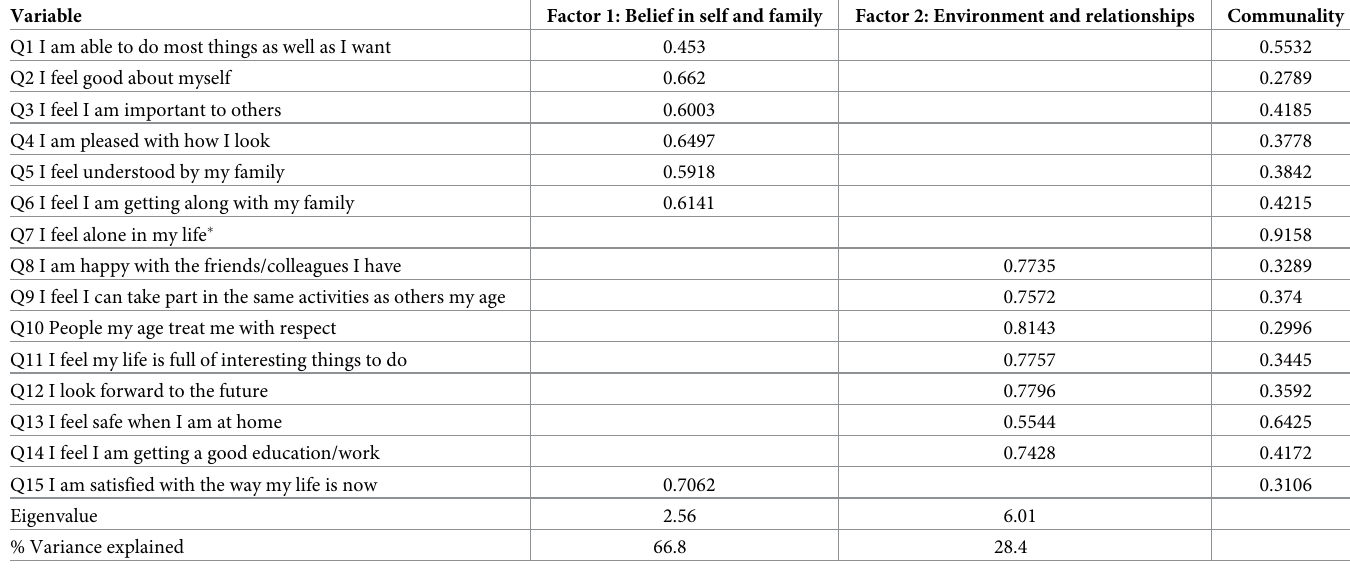
The scree parallel analysis and EFA identified that the 2-factor model was optimal for the YQOL assessment (Fig 1). Table 2 revealed the results of EFA. The majority of communalities’ values were moderate. The Kaiser-Meyer-Olkin measure of sampling adequacy was 0.933 indicating that the sample was adequate for EFA. The p-value of Bartlett’s Test of Sphericity was less than 0.01 ( χ 2 = 4517.330; Degrees of freedom = 105; p-value < 0.01) revealing that the EFA is useful for restructuring the YQOL. These factors comprised factor 1 “Belief in self and family” (7 items), and factor 2 “Environment and relationships” (7 items). Compared to the original instrument, Table 2. Exploratory factor analysis for Youth Quality of Life Instrument. Variable Factor 1: Belief in self and family Factor 2: Environment and relationships Communality 0.453